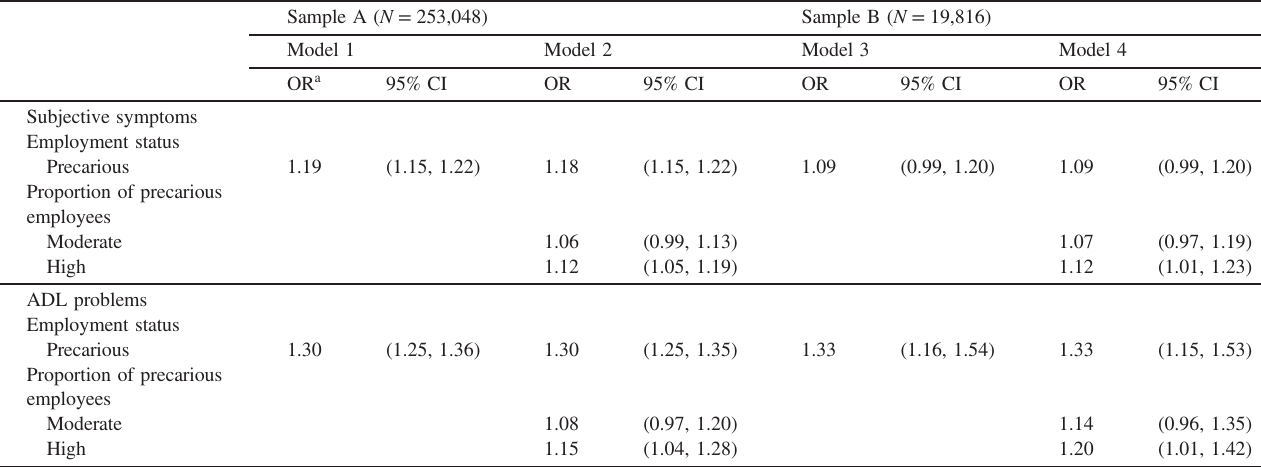
Table 5. Estimation results of multi-level logistic models to explain subjective symptoms and problems in activities of daily living for